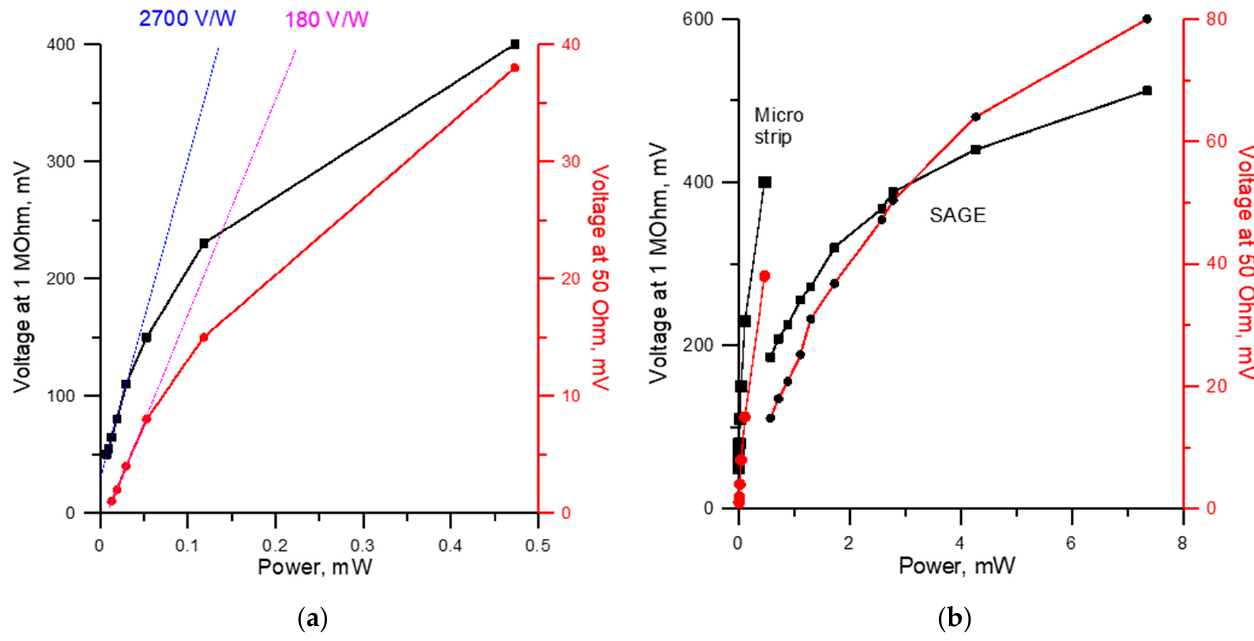
Figure 3. Detector signal voltage as a function microwave power produced by RadiaBeam microstrip detector ( a ). Sensitivity comparison of RadiaBeam detector with a commercial WR8 waveguide detector from SAGE Millimeter ( b ). Two times higher voltage is produced by RadiaBeam detector for the same input power at 0.5 mW.